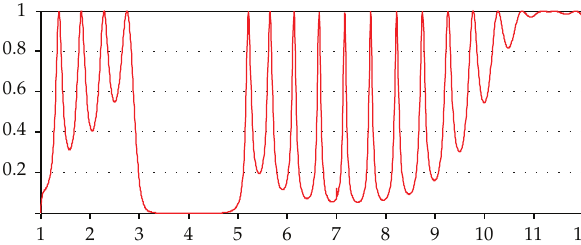
Figure 5: Animation of Figure 2 as the width of the barriers, a (cid:2) , varies from 1 /m to 3 /m (cid:3) 2.4MB MPG (cid:4) .